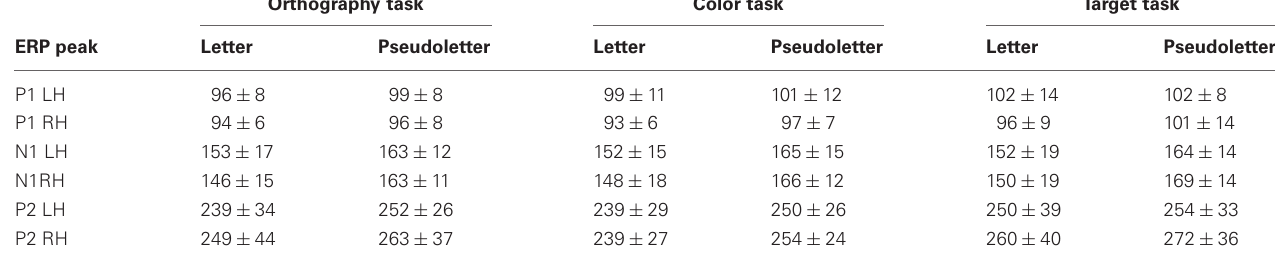
Table 3 | Peak EP latencies.